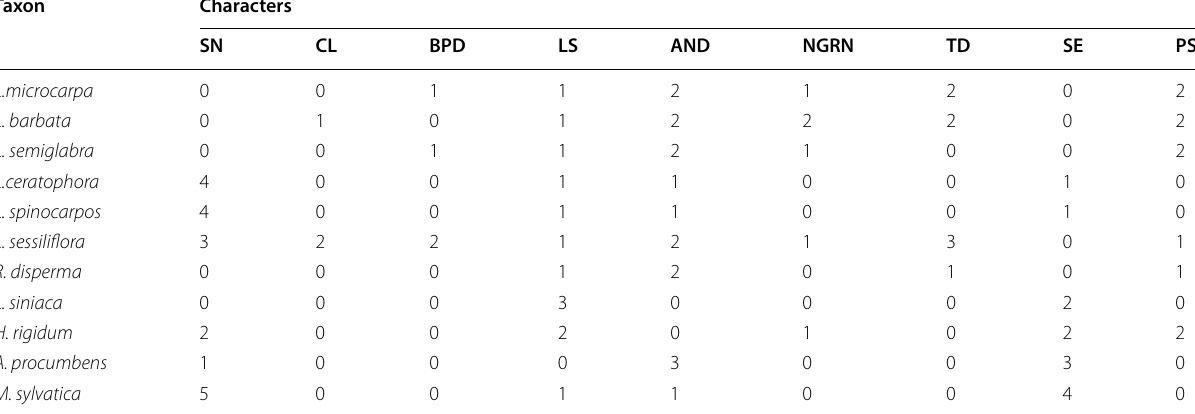
SN (shape of nutlet) including ovoid (0), semicircular (1), ovoid-rectangular (2), ovoid-triangular (3), pyramid (4), ellipse (5); CL (center line of nutlet) including absent (0), prominent with glochid (1), prominent with tubercles (2); BPD (base surface of prickles on desk) including lack of prickles (0), glabrous (1), verrucose (2); LS (Lamella status) including thread like (0), glossy (1), bumpy with verrucate (2), interrupt (3); AND (Appendage on nutlet desk) including papilla –verrucose (0), without appendage (1), with tuberculate and prickles (2), dome-shape papilla (3); NGRN (number of glochid row on nutlet edge) including lack of glochids (0), 1-row (1), 2-row. outer ones in a regular row (2); TD (tubercles on desk) including without spin (0), 2–3 spines (1), 4–5 spines (2), 5 spines (3); SE (surface emergence) including stellare- aculeate (0), veruucose-subverrucose (1), papilla- verrucose (2), Papilla (3), nonexpressiate (4); PS (prickles surface) including lack of prickles (0), verrucose (1), glossy